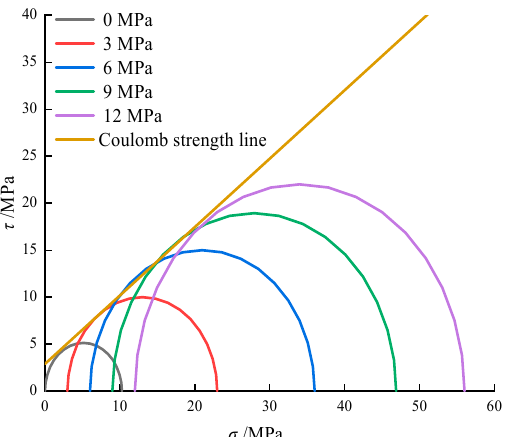
Figure 7. Mohr circles of triaxial compression test under different confining pressures.